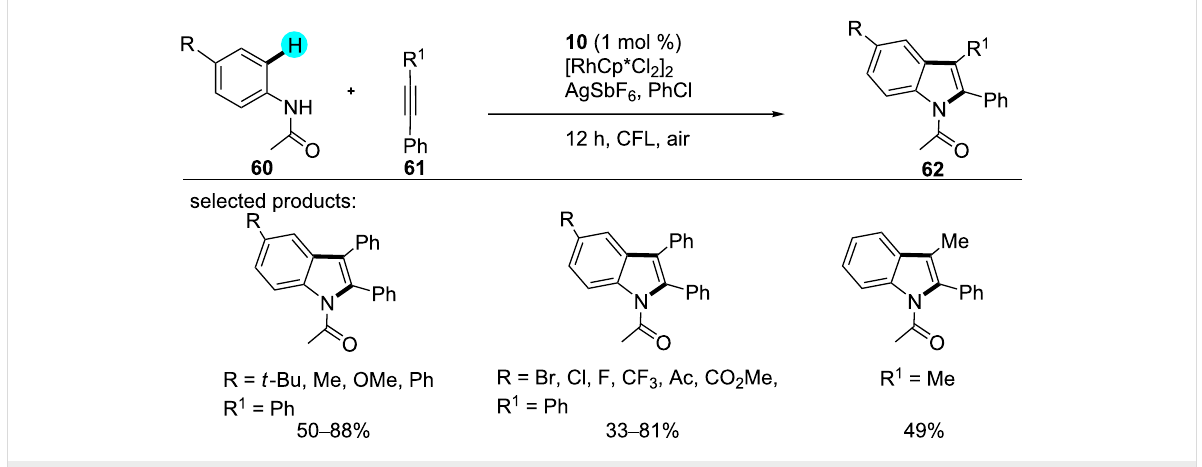
Scheme 7: Synthesis of indoles via C–H cyclization of anilides with alkynes.